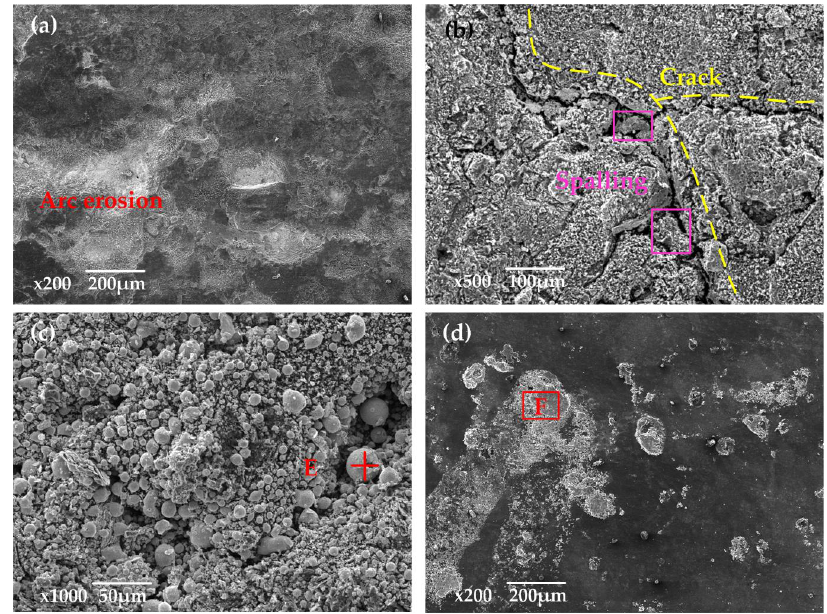
Figure 13. SEM of the worn surfaces at high arcing rate (100 km·h −1 , 40 s, 120 A): ( a ) B = 8 N, f = 0.426 Hz, arcing rate = 6.65%; ( b ) B = 41 N, f = 0.426 Hz, arcing rate = 16.141%; ( c ) ablation products from ( b ); ( d ) debris from ( b ).